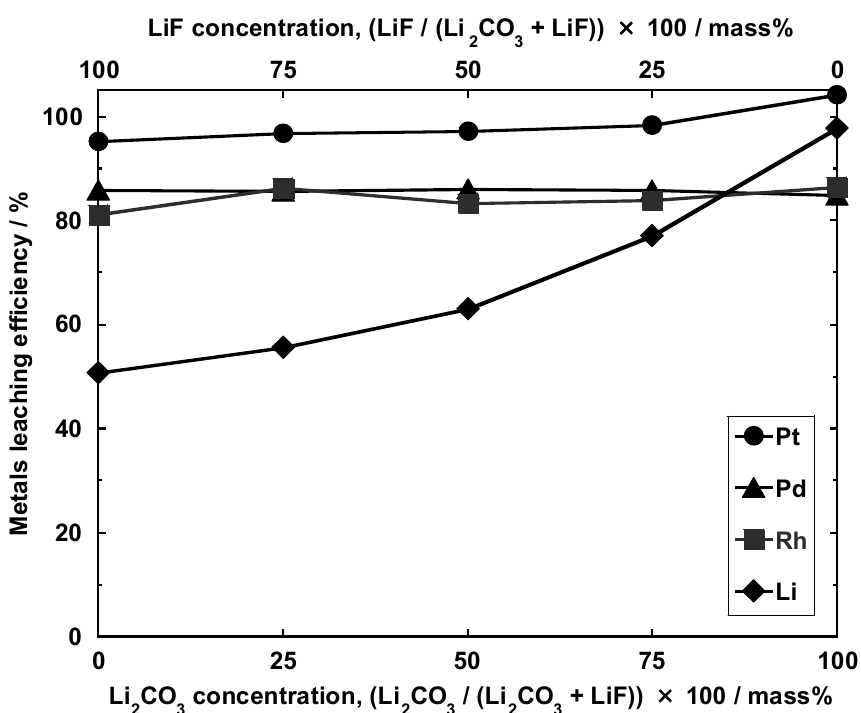
Li CO concentration, (Li CO / (Li CO + LiF)) × 100 / mass% 2 3 2 3 2 3 Figure 6. Pt, Pd, Rh, and Li leaching efficiencies in the solution samples obtained under conditions I-C-1, I-C-2, I-C-3, I-C-4, and I-C-5. Dissolution conditions: 12 M HCl at 180 °C for 2 h.